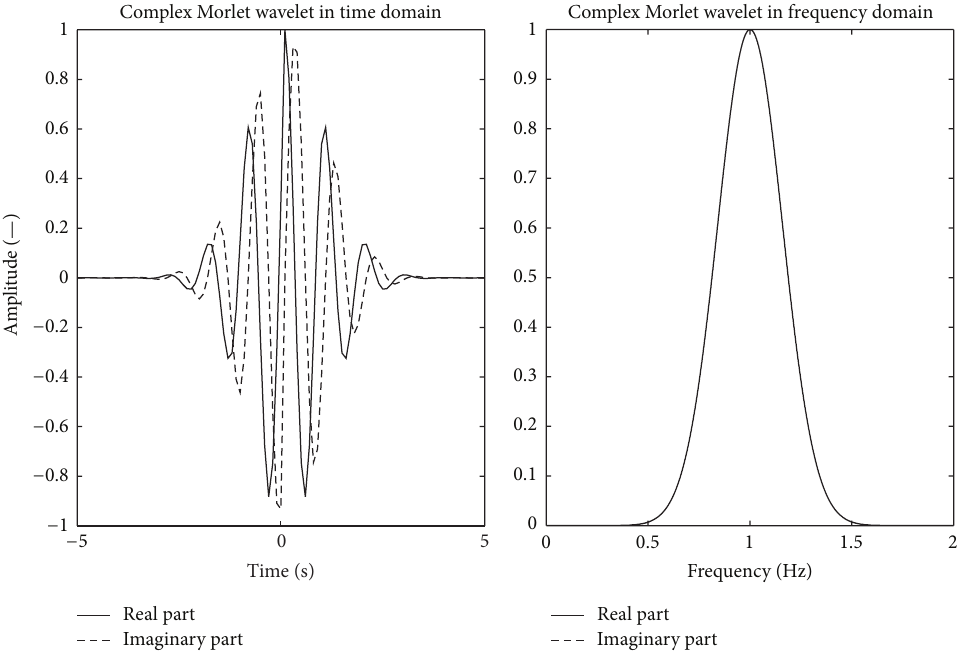
Figure 1: Complex Morlet wavelet